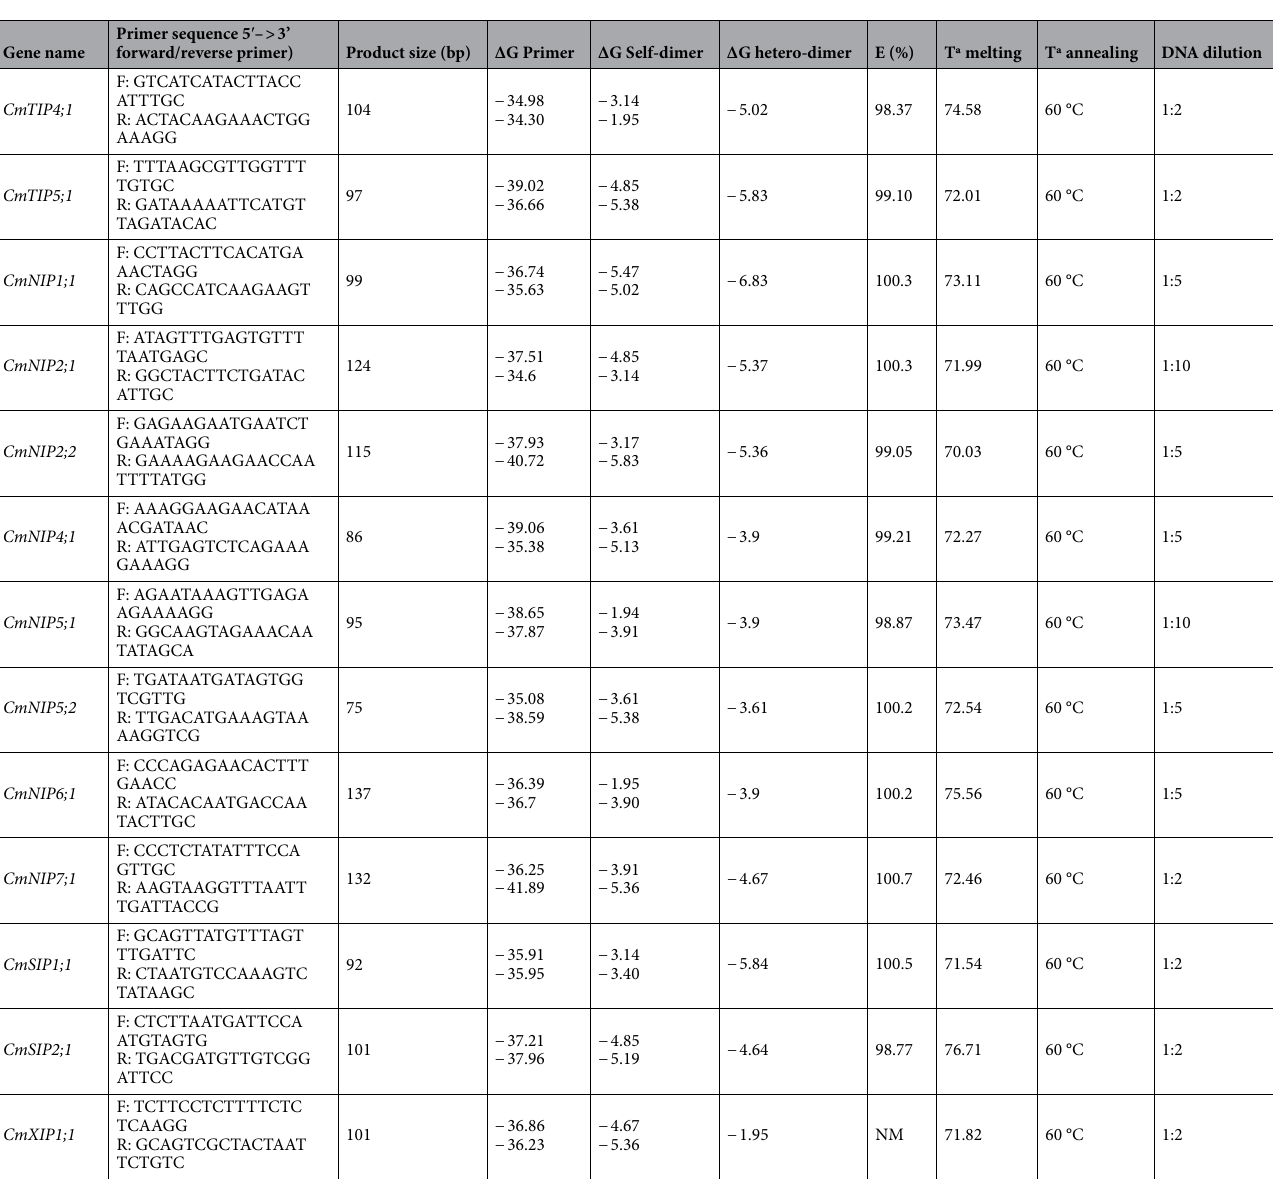
Table 1. Primer used for measurement of C . melo (Cm) aquaporins expression by RT-qPCR. Columns: gene name, primer sequence: up the forward (F) and below the reverse (R), product size (bp), ΔG primer, ΔG